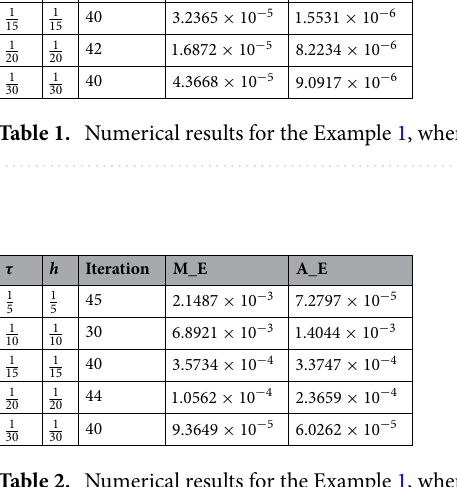
Table 2. Numerical results for the Example 1, where γ = 0.5 .